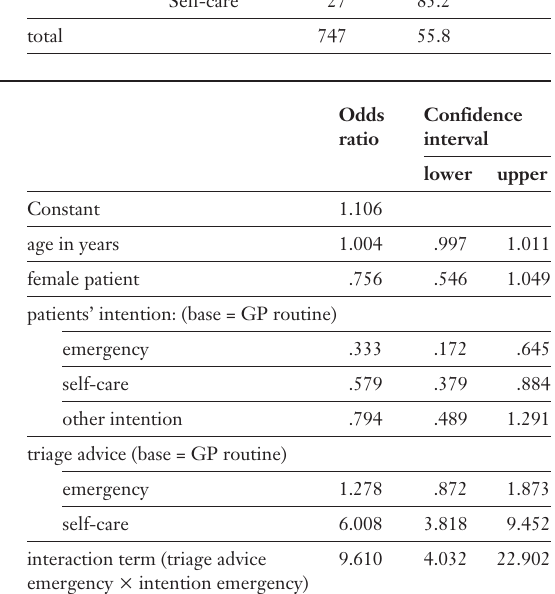
patients’ intention: (base = GP routine)